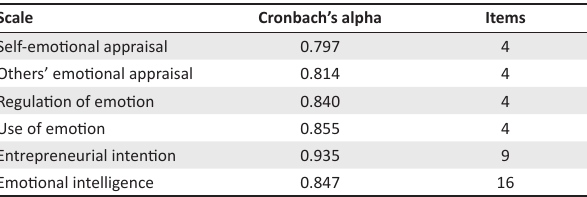
TABLE 1: Internal consistencies.